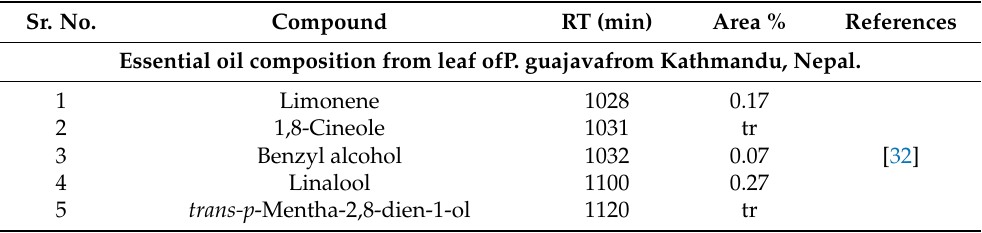
Table 4. Phytochemicals identified from the leaf essential oil extracted from P. guajava . Sr. No. Compound Area